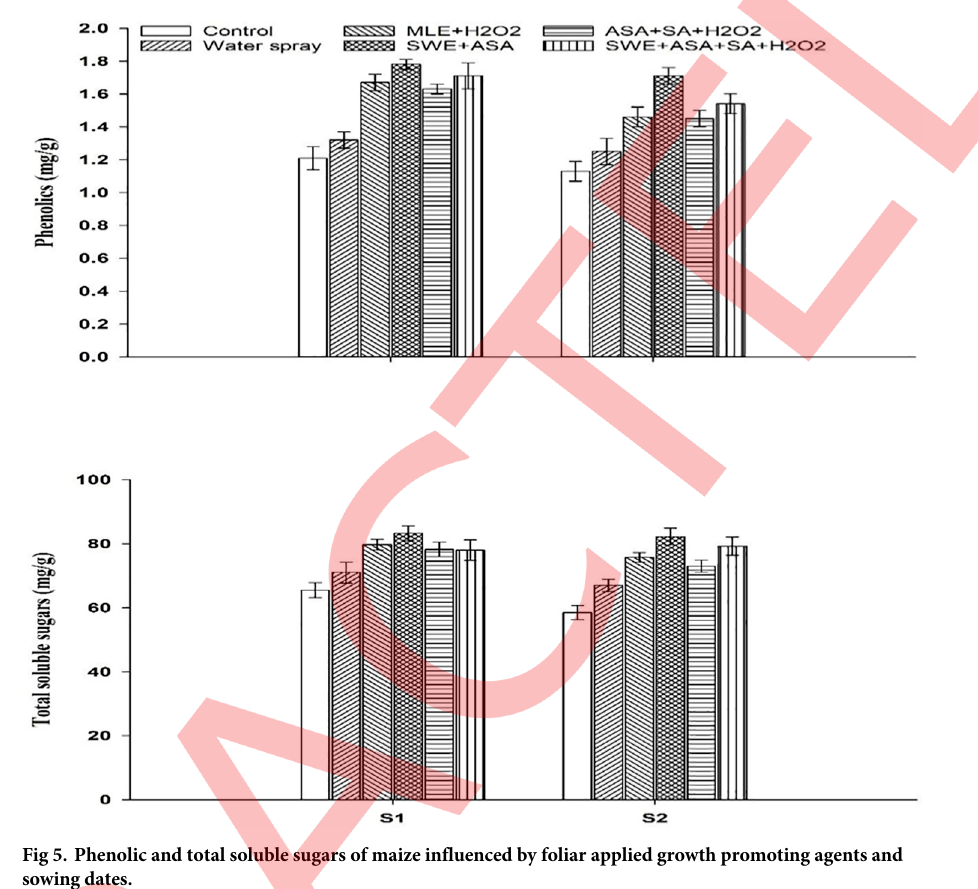
forbearance in plants such as chilling, heat, drought and salinity [22]. The following study was aimed for the improvement of the thermotolerance of the spring maize by using the foliar application of growth promoting substances at critical growth stages under early and optimum sowing dates. The results obtained are similar to many researchers who have observed the pos- itive effects of these growth promoting substances when applied exogenously to different